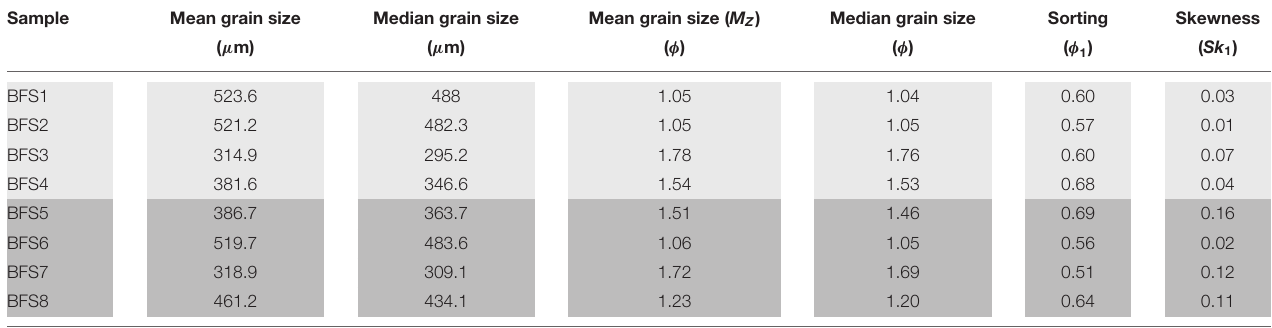
TABLE 2 | Summary of grain size analysis, including mean and median grain size, sorting, and skewness. Sample